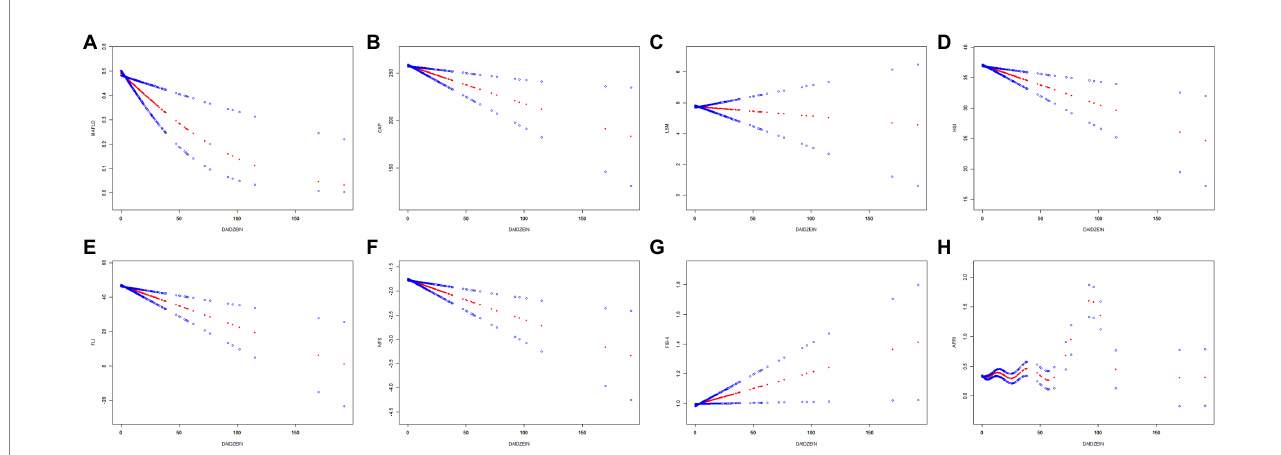
FIGURE 2 The relationship between daidzein intake and MAFLD prevalence, CAP, LSM, HSI, FLI, NFS, FIB-4, and APRI, respectively. The generalized additive model (GAM) was used to assess the relationship between daidzein intake and MAFLD prevalence (A) , CAP (B) , LSM (C) , HSI (D) , FLI (E) , NFS (F) , FIB-4 (G) , and APRI (H) , respectively. The red dashed line represents the smoothed curve fit between the variables. The blue dashed line represents the 95% confidence interval of the fit. Age, sex, and race/ethnicity were adjusted in the model. MAFLD, metabolic associated fatty liver disease; CAP, controlled attenuation parameter; LSM, liver stiffness measurement; HSI, hepatic steatosis index; FLI, fatty liver index; FIB-4, fibrosis-4; NFS, NAFLD fibrosis score; APRI, AST to platelet ratio index.